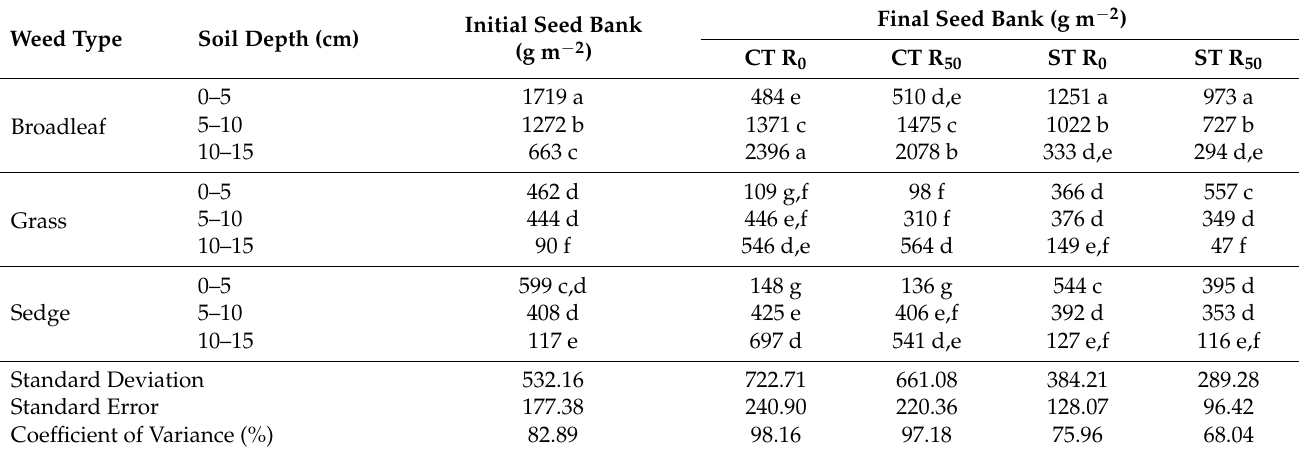
Table 9. Effect of tillage and residue levels on the weed dry matter (g m − 2 ) as a group at different soil depths (average for